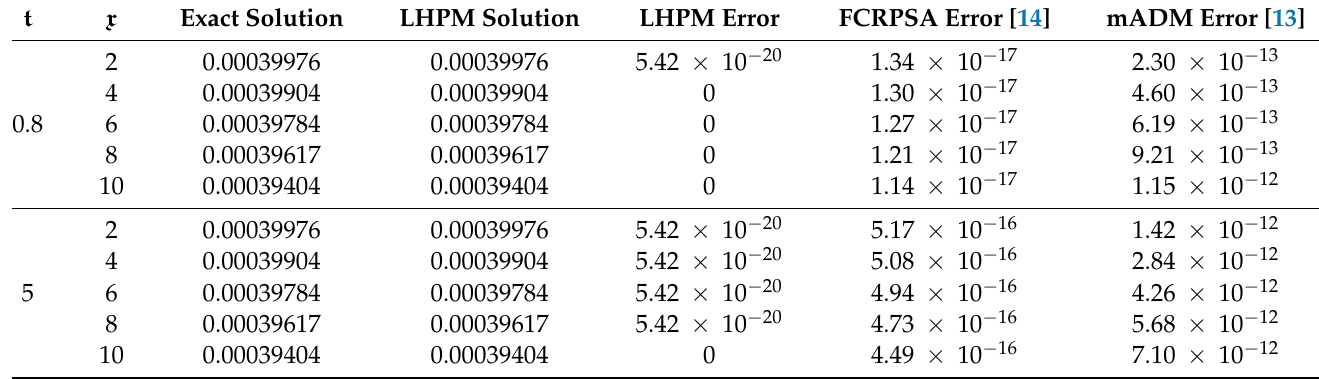
Table 1. Comparison of LHPM errors with FCRPSA and mADM errors in Example 3 when β = 1 and k =